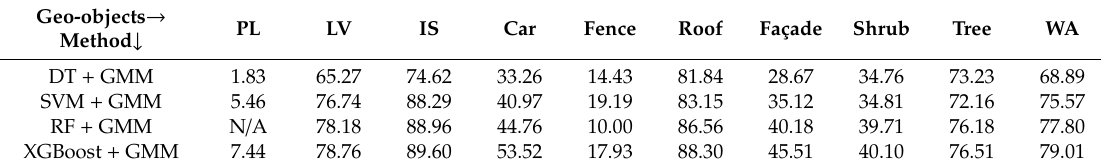
Table 1. F1 score of the proposed method (%).